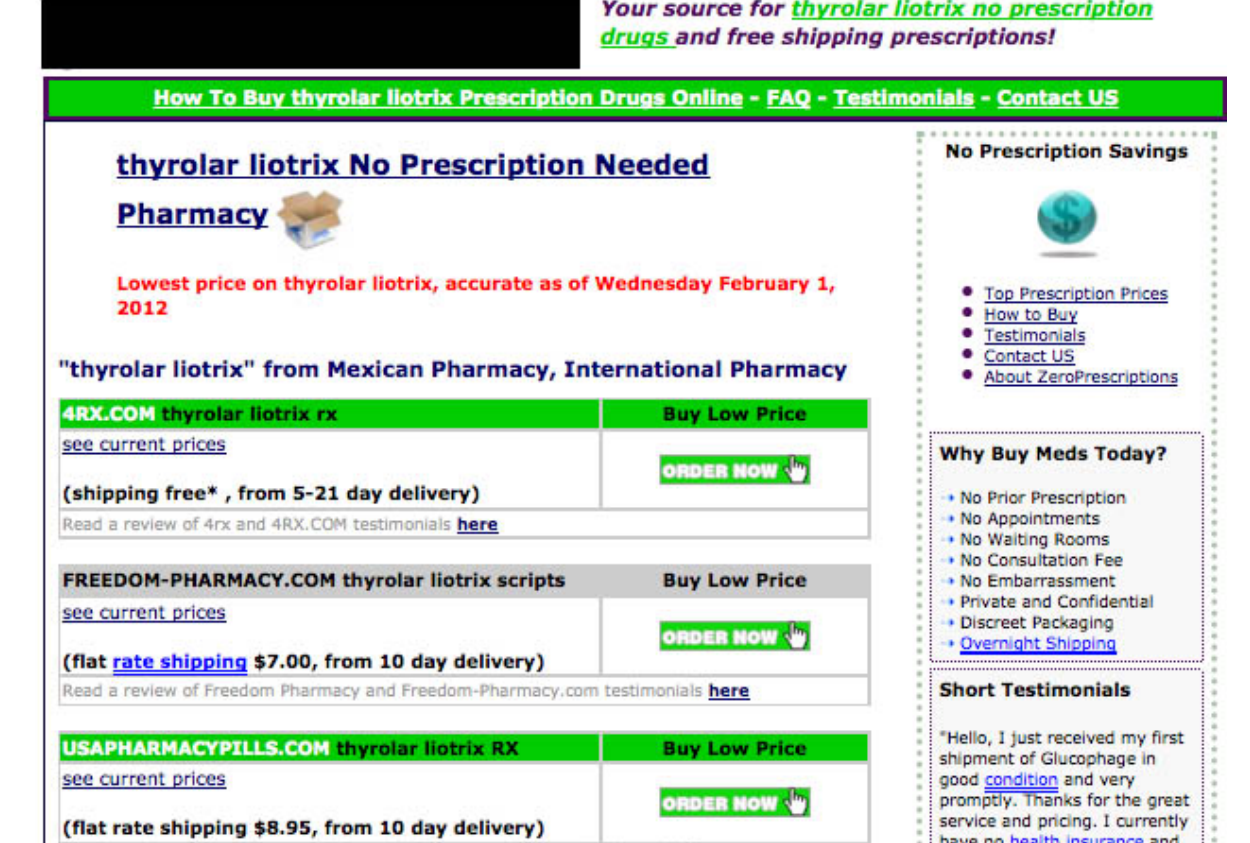
Figure 3. Intermediary site marketing products as no-prescription drug.